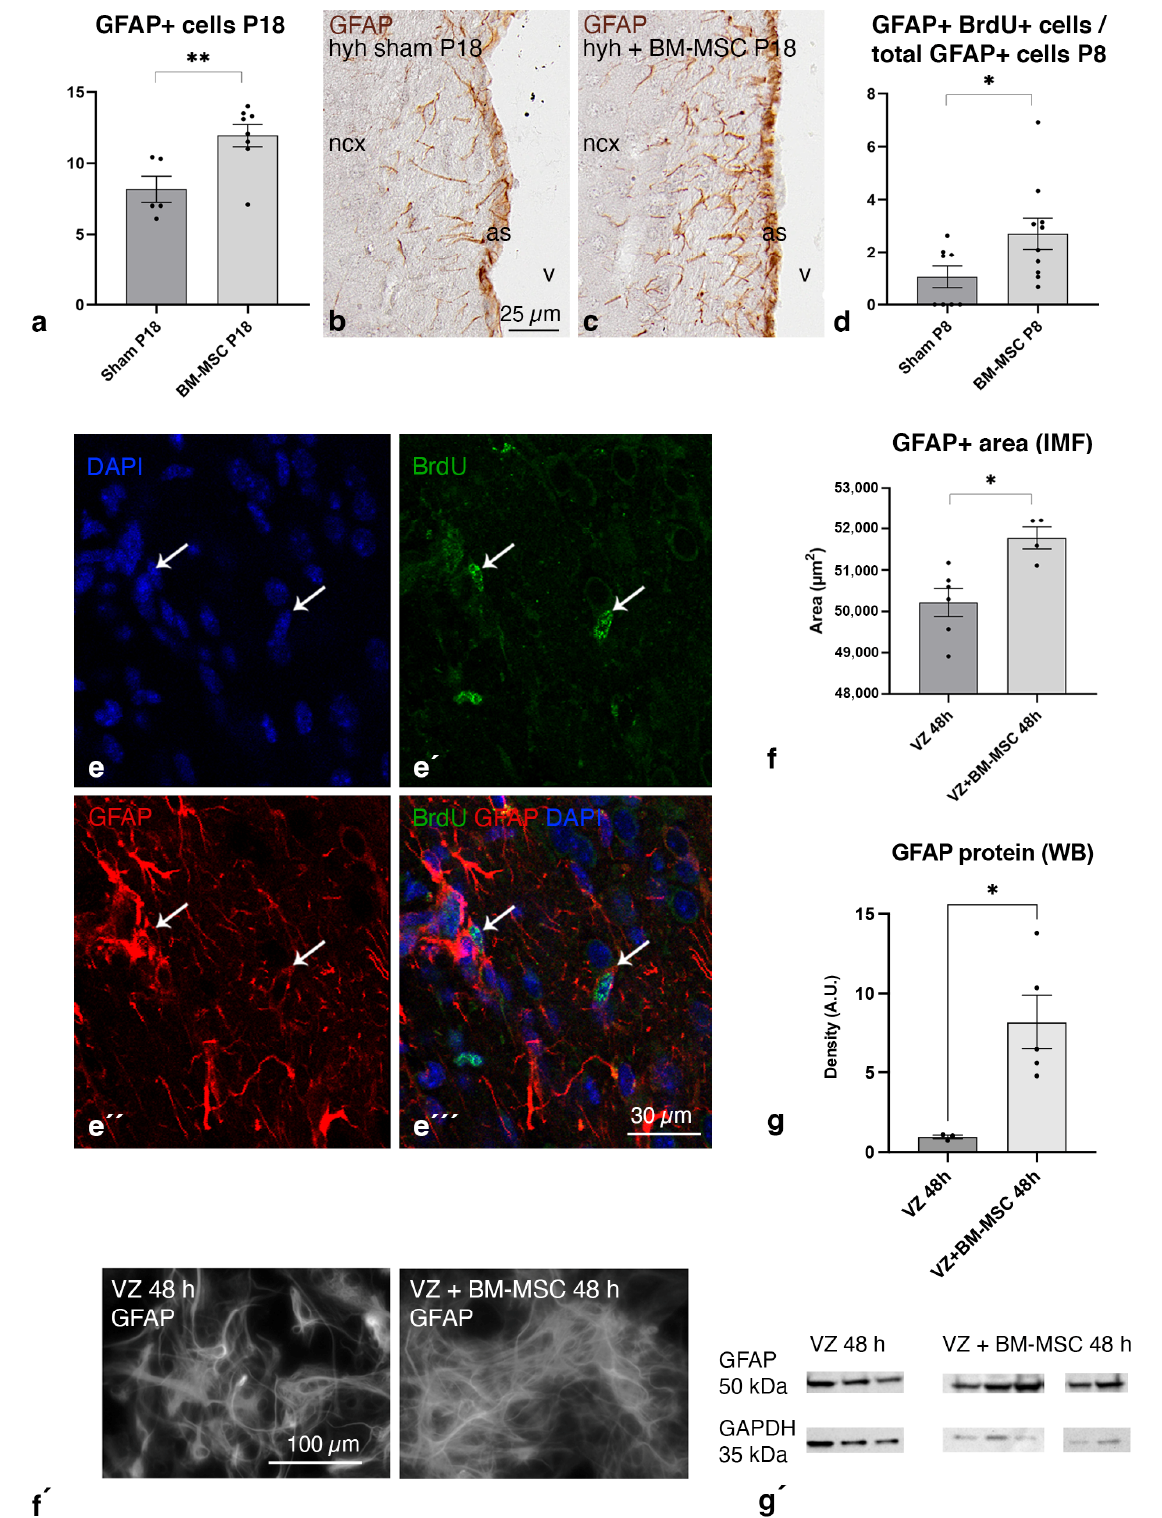
Figure 6. Astroglial stimulation after BM-MSC transplantation in hydrocephalic hyh mice. Density of ( a ) GFAP+ cells in the sham-injected (sham, n = 5) and BM-MSC-transplanted ( BM-MSC , n = 8) hydrocephalic hyh mice at P18. Representative images used for quantification with GFAP labeling in paraffin sections of the neocortex (ncx) from ( b ) a hydrocephalic hyh mouse sham-injected ( sham ) and ( c ) a hydrocephalic hyh mouse transplanted with BM-MSCs (BM-MSC). Magnifications are the